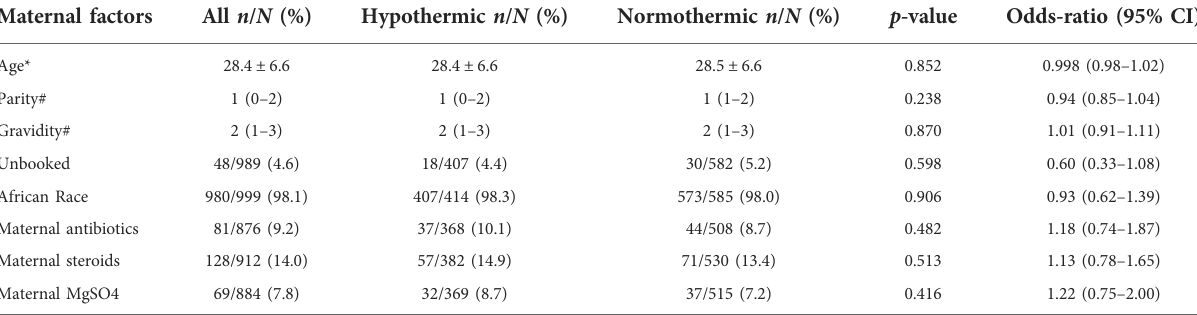
TABLE 1 Maternal characteristics of study